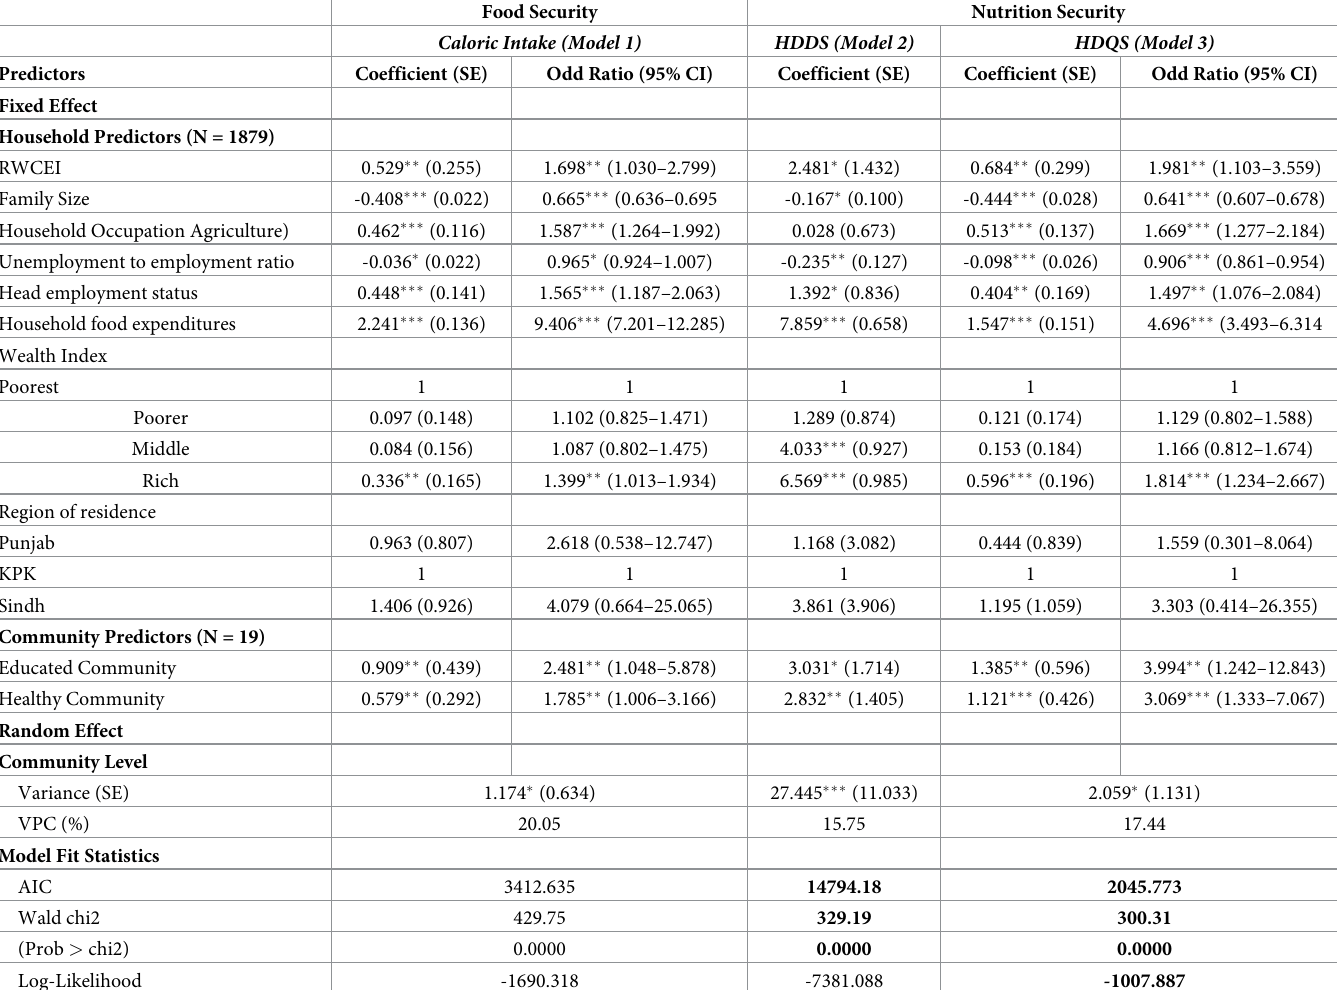
Table 2. Results from multi-level mixed-effect models of food security and nutrition security are